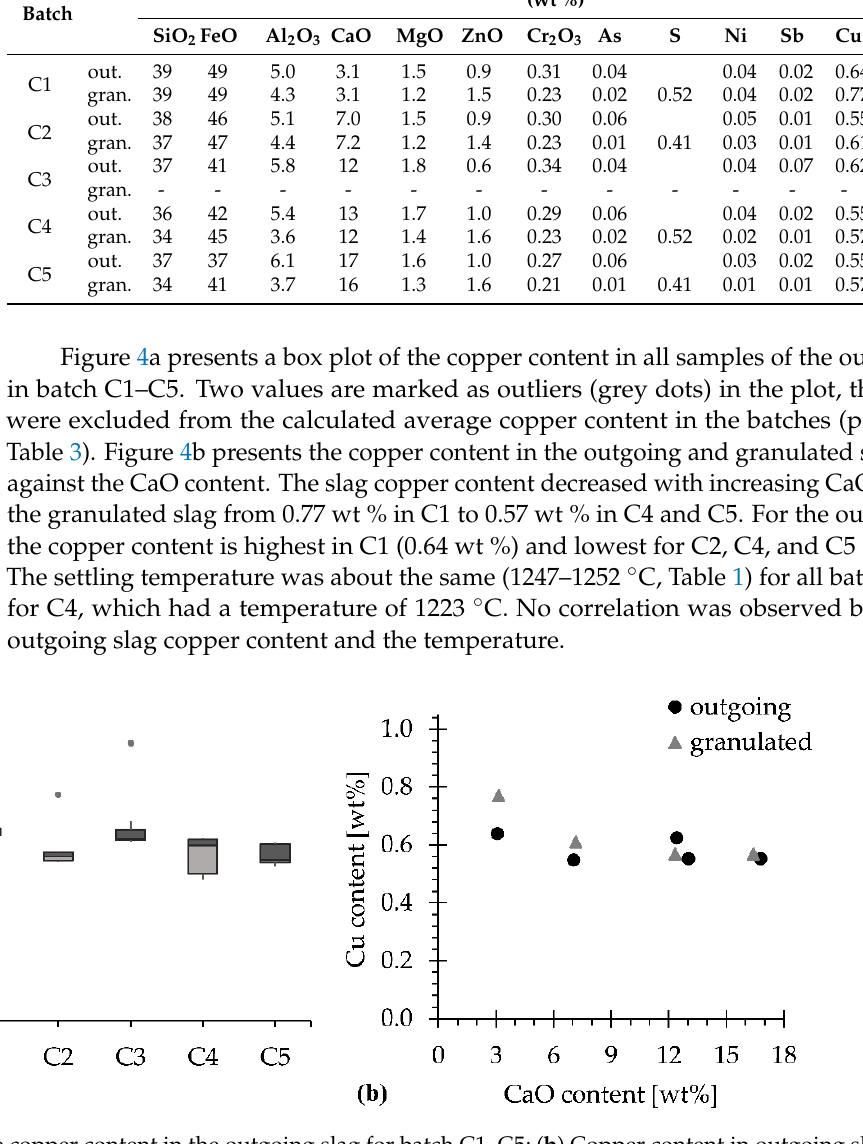
Figure 4. ( a ) Box plot of the copper content in the outgoing slag for batch C1 – C5; ( b ) Copper content in outgoing slag and granulated slag plotted against the CaO content.